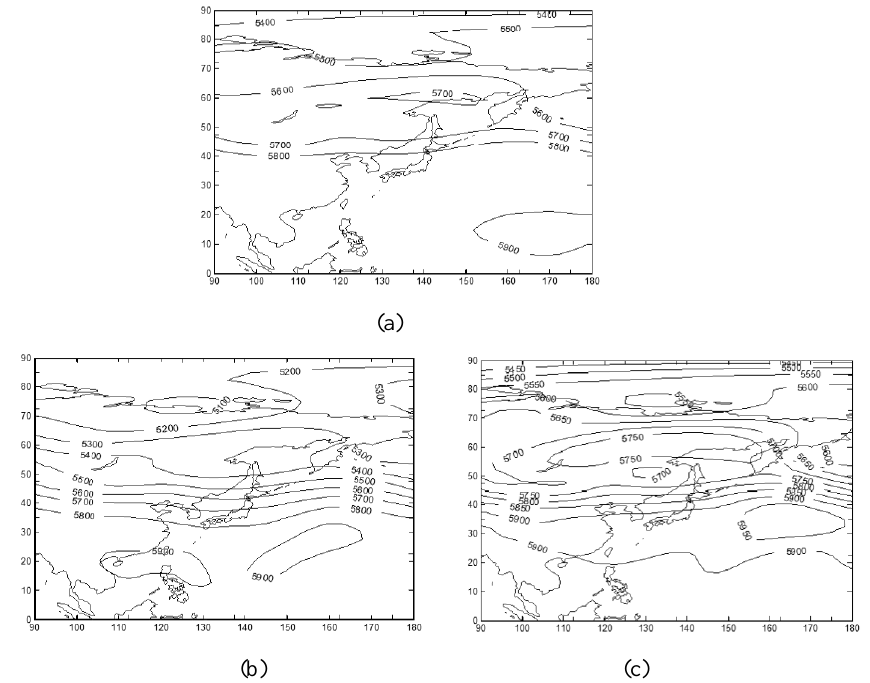
Fig.9 The summer SH potential fields in 2003 reconstructed (a) before Fig. 9. The summer SH potential fields in 2003 reconstructed (a) before combination with b 9 = − 4, and (b) after combination of the high equilibrium and (c) the low equilibrium with b 9 = 7. combination with 4 b = - ; (b) and after combination of the high equilibrium and 9 (c) the low equilibrium with 7 b = 9